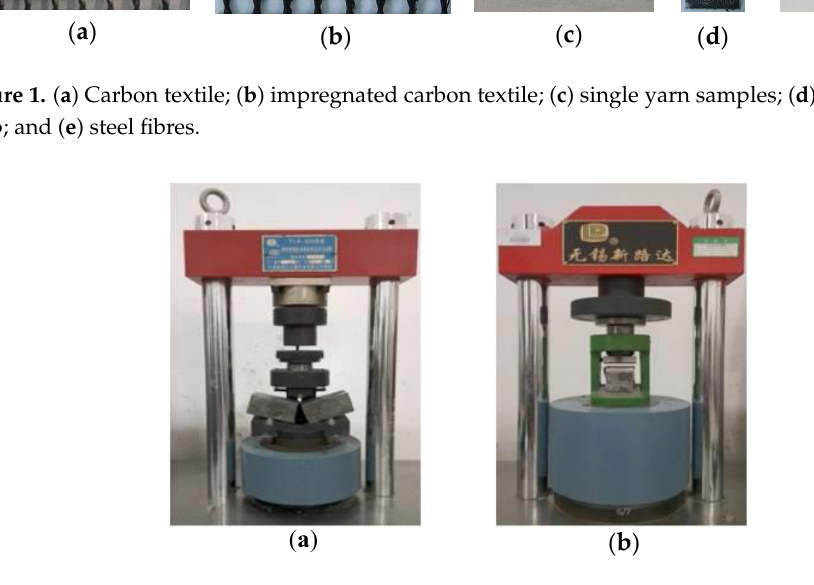
Figure 2. Setup of ( a ) the three-point bending and ( b ) compression test of the plain matrix.